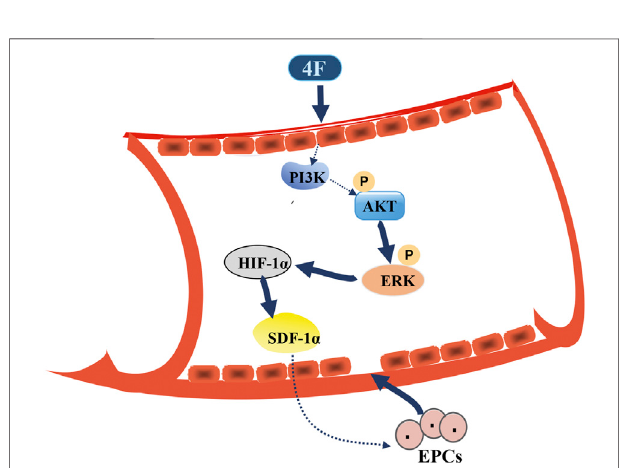
FIGURE 8 | Schematic diagram for 4F promoting SDF-1 α expression in vascular endothelial cells. 4F can upregulate the levels of HIF-1 α in mice and endothelial cells by activating PI3K/Akt/ERK signaling pathway and thus promotingthelevelofSDF-1 α .Elevated SDF-1 α inblood circulation may mobilize EPCs in the bone marrow to migrate to the site of vascular intimal injury where EPCs differentiate into mature ECs and participate in the repair of vascular endothelial